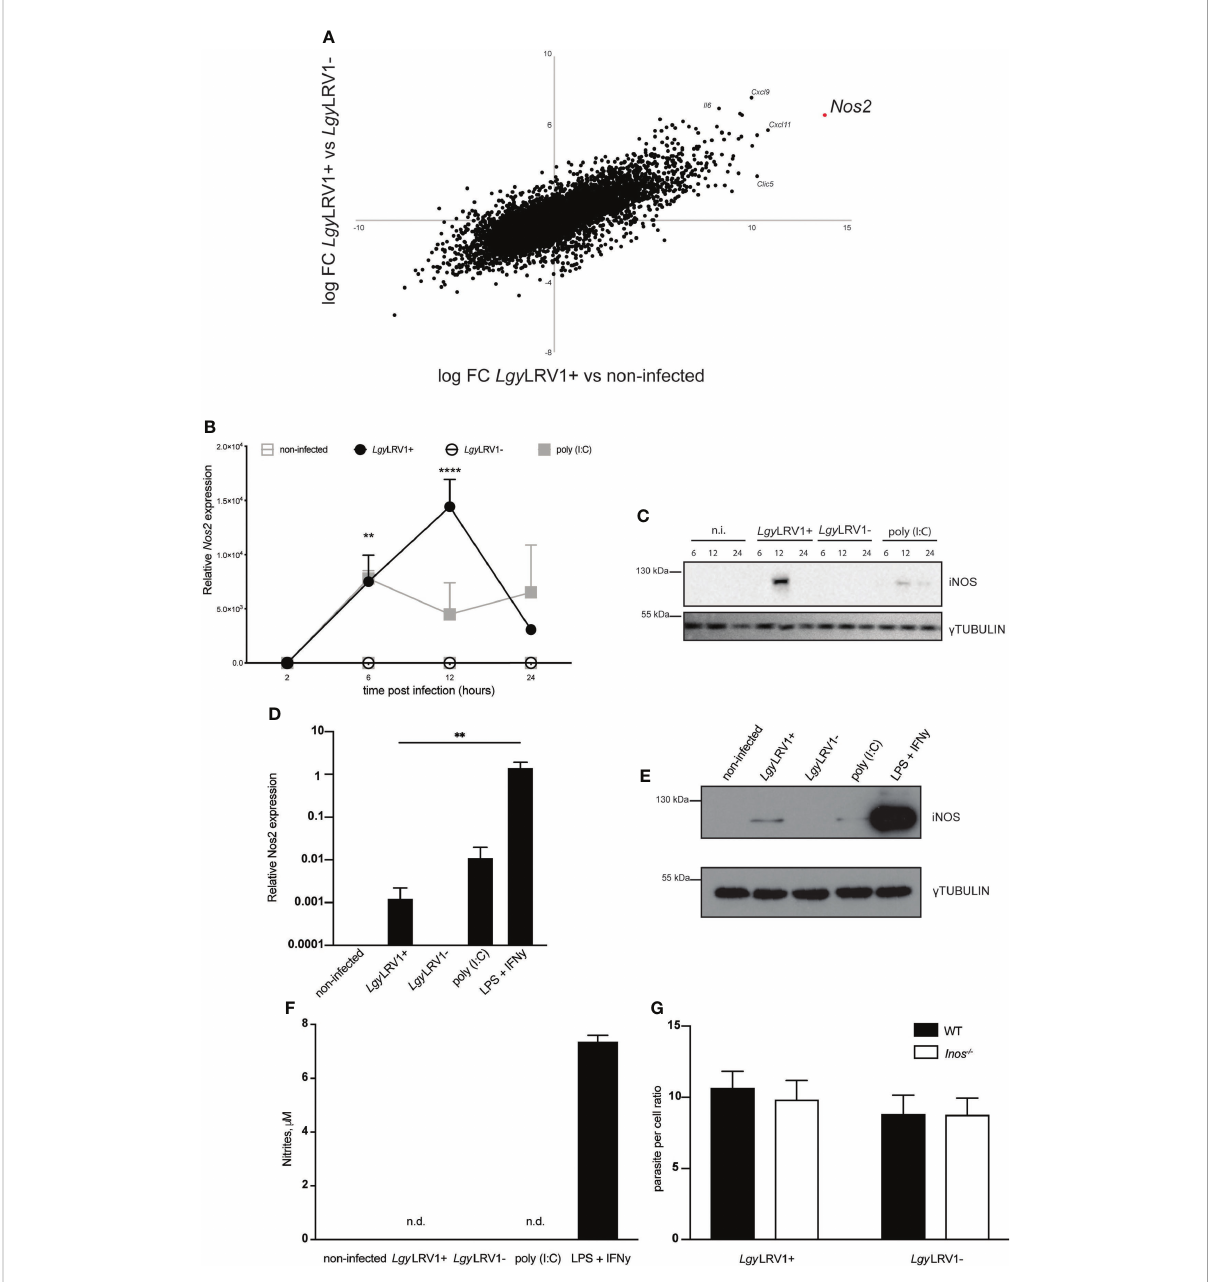
FIGURE 1 Lgy LRV1+ infection induces iNOS expression in murine BMDM. (A) WT BMDMs were infected with Lgy LRV1+, Lgy LRV1- (MOI 5) or left untreated for 8h. Total RNA were extracted and full RNAseq analysis was performed. Scatter-plot shows all present genes comparing Lgy LRV1+ vs non- infected (x-axis) and Lgy LRV1+ vs Lgy LRV1- (y-axis), (n = 4). (B) WT BMDMs were infected with Lgy LRV1+, Lgy LRV1- (MOI 10), stimulated with poly (I:C) (2 m g/ml), or left untreated, for 2, 6, 12 or 24h. RT-PCR was used to measure L32 -normalized Nos2 expression. (C) WT BMDMs were infected, or treated as in (A) . Total cell lysates were analyzed by western blot for iNOS and g -tubulin expression as loading control at indicated time points. (D) WT BMDMs were infected, or treated as in (A) for 12h. LPS (1 m M) and IFN- g (0.1 U/ m l) stimulation were used as controls. RT-PCR was used to measure L32 -normalized Nos2 expression. (E) WT BMDMs were infected, or treated as in (C) . Total cell lysates were analyzed by western blot for iNOS and g -tubulin expression as loading control. (F) WT BMDMs were infected, or treated as in (C) . Upon 48h supernatants were collected and levels of nitrites were measured using Griess assay. (G) WT or Inos -/- BMDMs were infected with Lgy LRV1+, or Lgy LRV1- (MOI 10) for 48h. Levels of parasitaemia were analysed using high content microscopy. Data show mean ± SD from a representative of three independent experiments (A, C, E and F) . Representative blots are shown from at least three independent experiments in (C, E) n.i. – non- infected. n.d. - not detected. Data were analyzed using unpaired Student ’ s t test. Not signi fi cant (NS), **p < 0.01, and ****p <